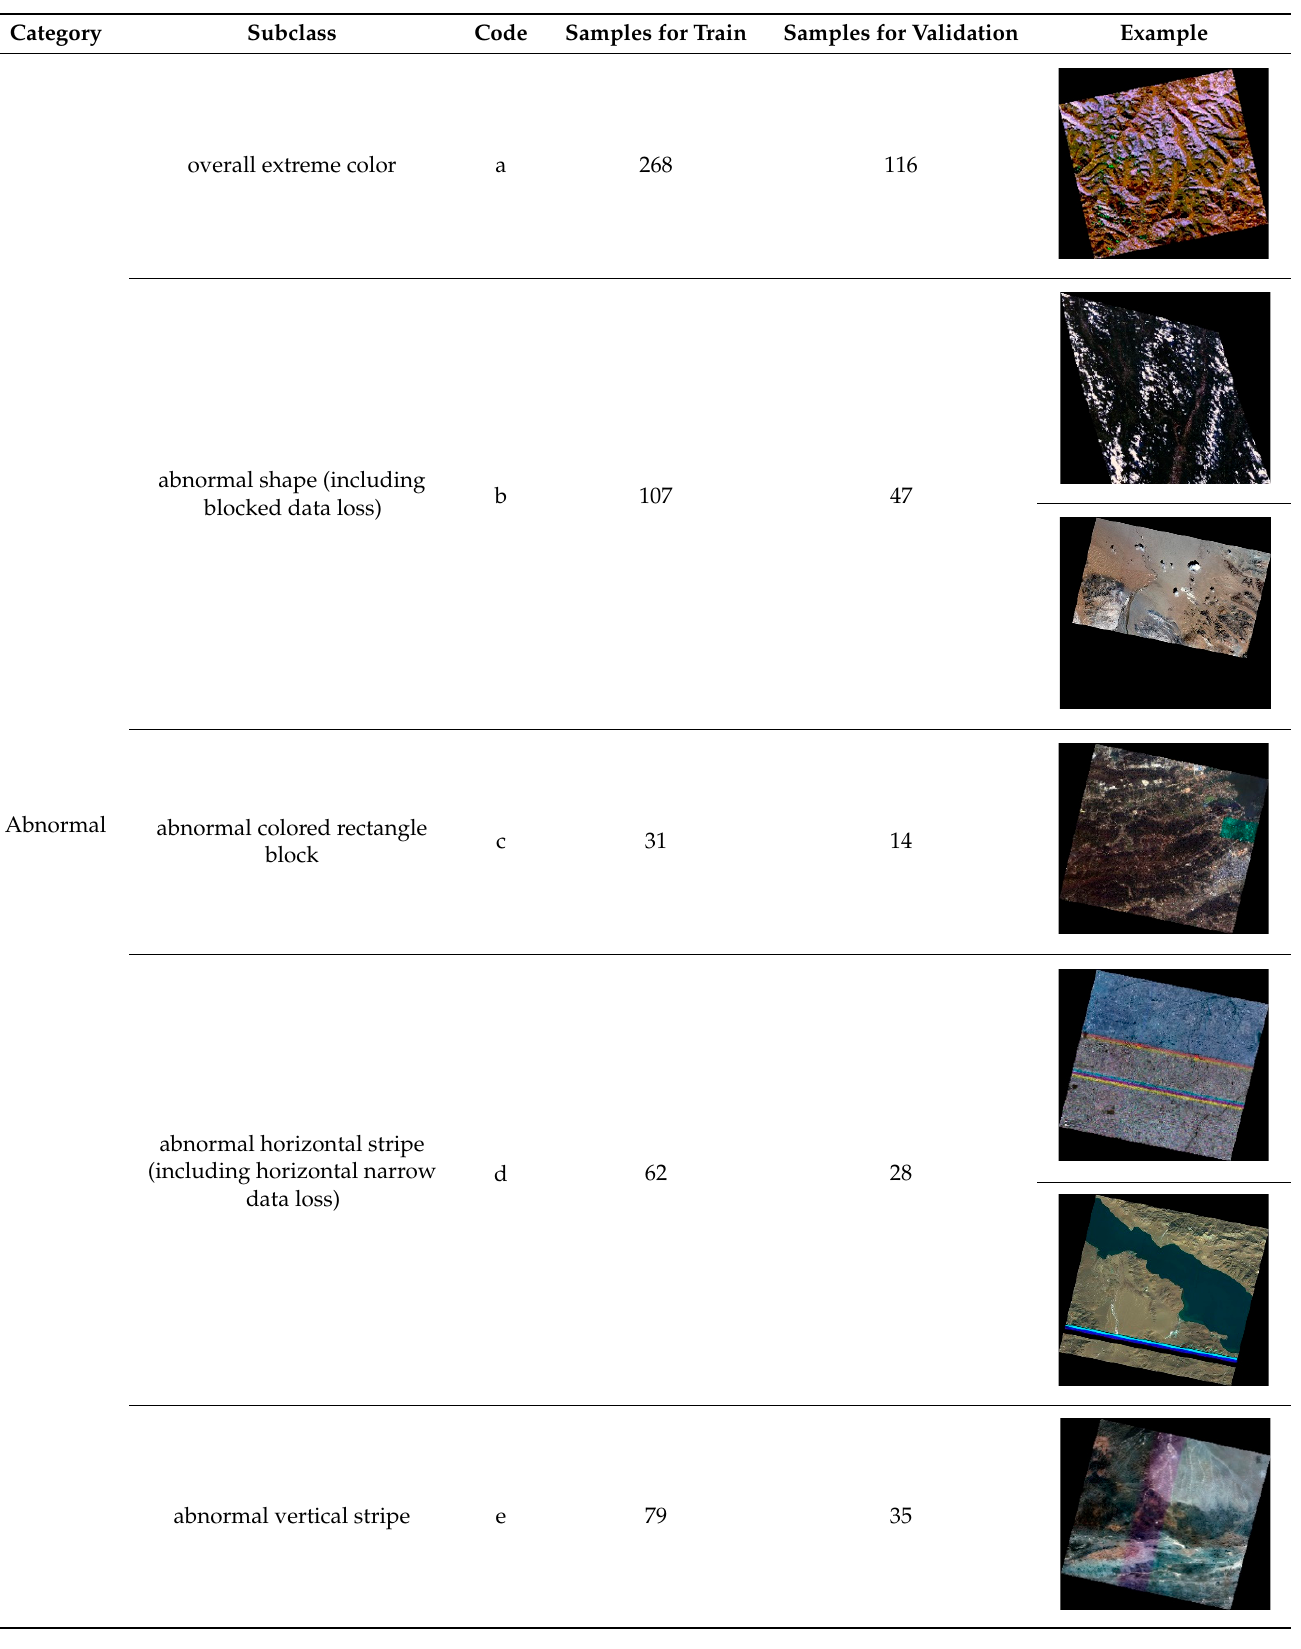
Table 1. Numbers and examples of samples in the dataset.